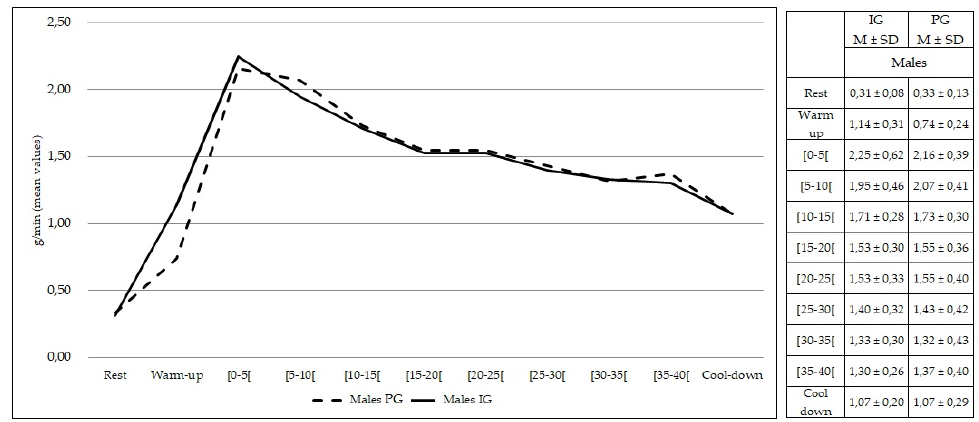
Figure 11. Respiratory exchange ratio values during rest, exercise, and cool-down in females (inter- vention group vs. placebo group). Data are expressed as mean ± standard deviation. IG: intervention group; PG: placebo group.